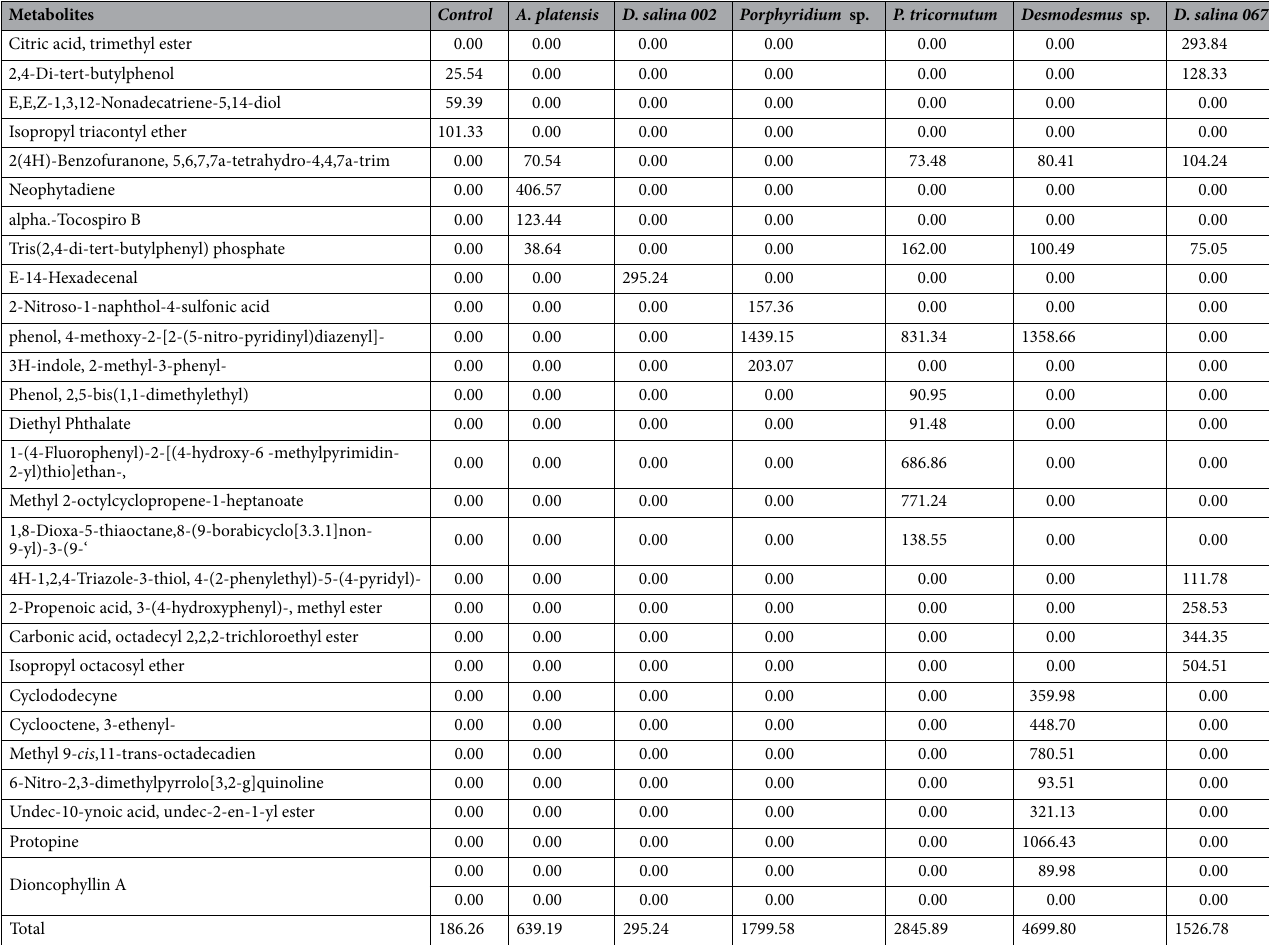
Table 4. Effect of polysaccharides treatments on profile of others metabolites (µg g −1 ) in tomato